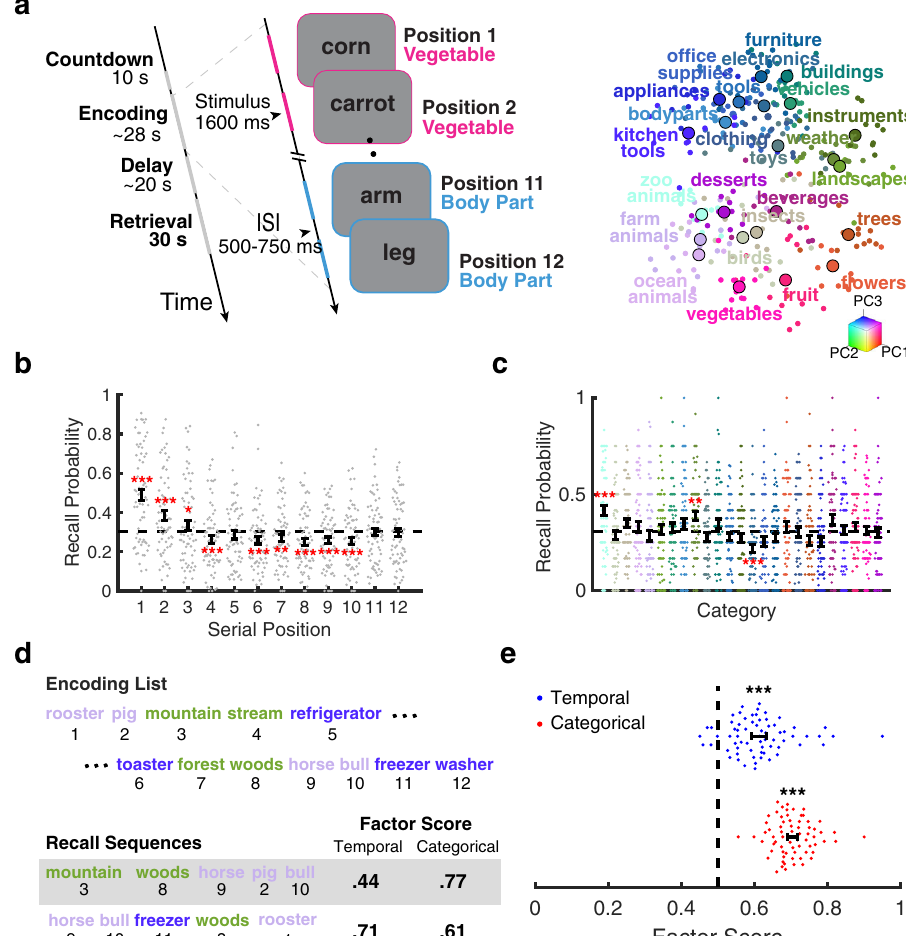
Fig. 1 Task and behavioral results. a Schematic of the free-recall task. Left: Task timeline for a single recall trial, highlighting the list structure and timing during the encoding period. Subjects completed 25 lists per experimental session. Right: Category representations of stimuli. Each point indicates a word ’ s semantic representation along with the fi rst three principal components of the word2vec 28 space. Larger points denote the midpoint of all stimuli within a category. Words with similar meaning are spatially proximal. b Recall performance by serial position. Compared to average recall (dashed line), subjects ( n = 69, indicated by individual points) recalled signi fi cantly more items from early serial positions. c Recall performance by category. Plotting convention follows panel ( b ). d Factor scores for example recall sequences. Factor scores above 0.5 indicate above chance levels of temporal or